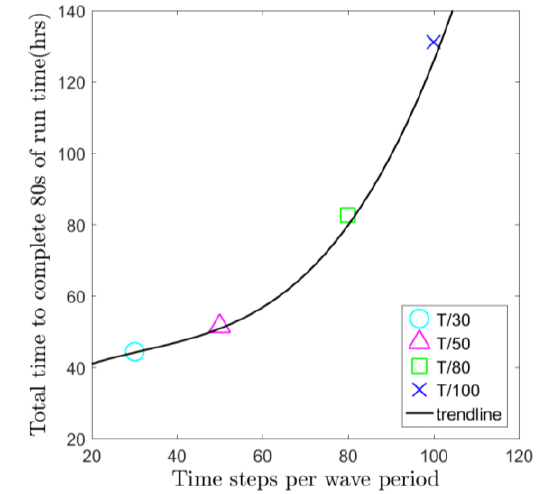
Figure 7. Computational speed of numerical model with different mesh